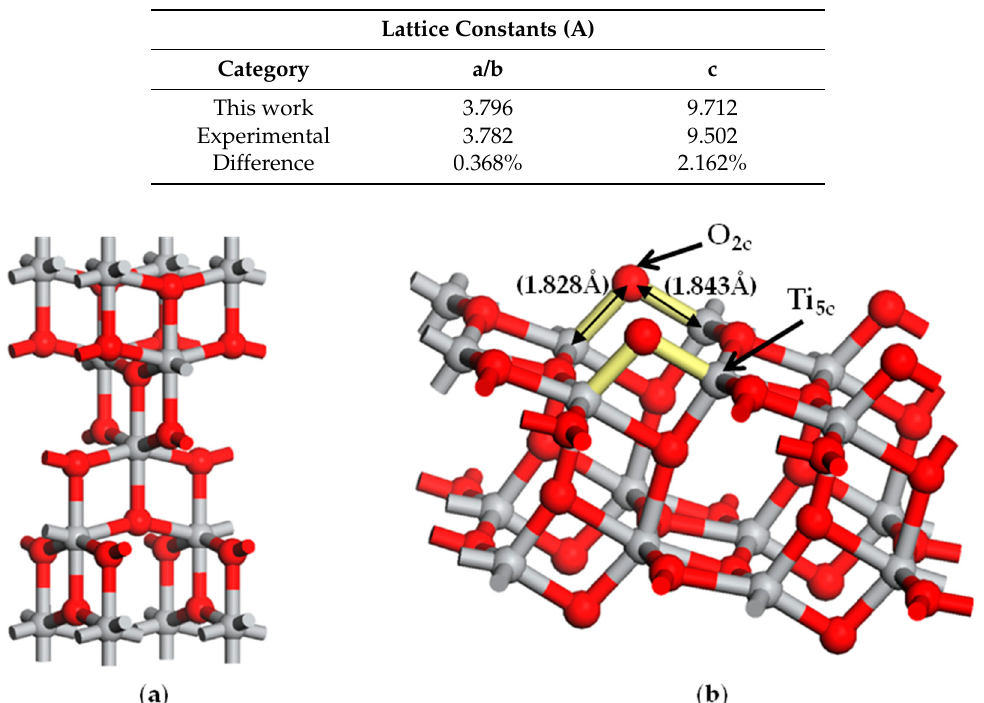
Table 1. Lattice constants for anatase TiO 2 and their differences with respect to experimental measurements.